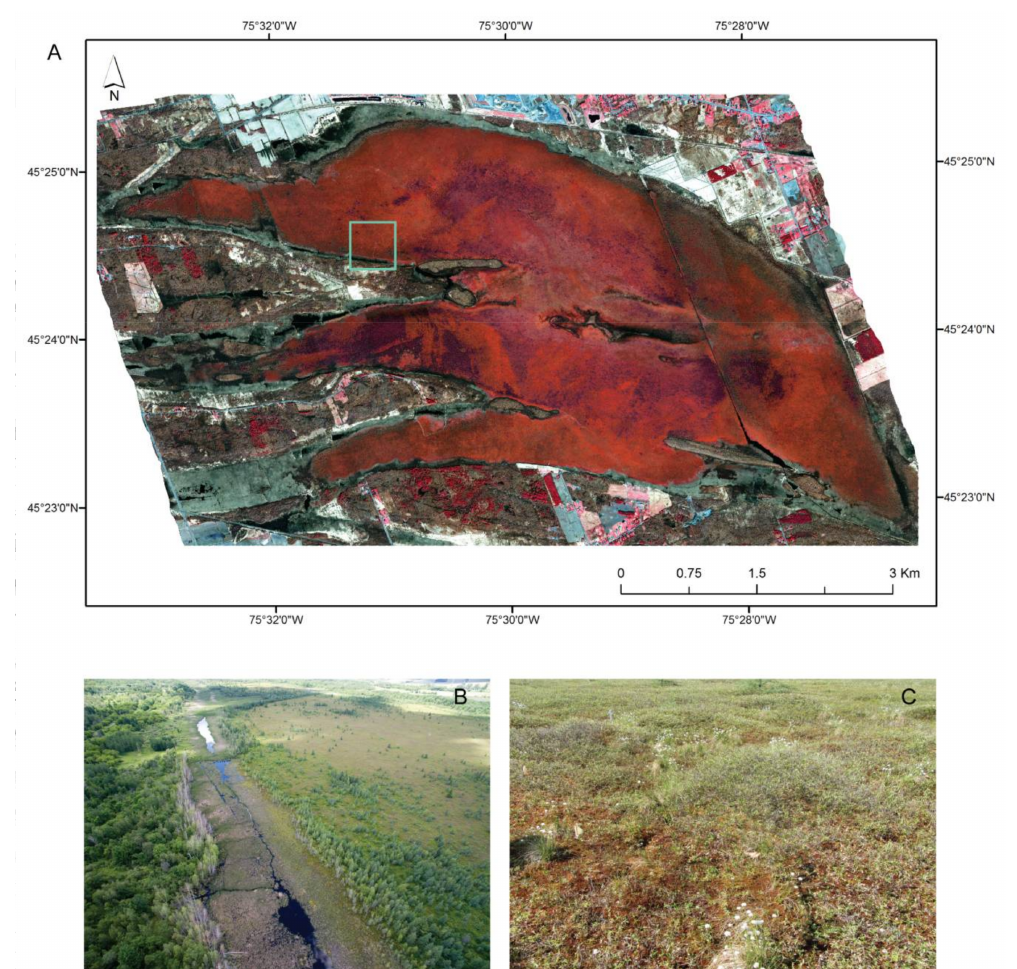
Figure 1. ( A ) CASI hyperspectral image mosaic of 12 flight lines acquired 20 April 2016 (R: 756 nm, G: 689 nm, B: 550 nm) illustrating the entire study area. The green box corresponds to the Mer Bleue Peatland Observatory where most of the in situ research is carried out. ( B ) Unmanned aerial vehicle (UAV) photograph of the peatland margin illustrating a beaver pond with open water, Typha angustifolia and floating Sphagnum moss. The peatland can be seen to the right (north) of the beaver pond with mixed forest on mineral soil to the left (south); ( C ) Ground photograph illustrating the small-scale (<50 cm) hummock-hollow microtopography. Brown-red areas correspond to moss vegetation in hollows, and green areas correspond to vascular plants in